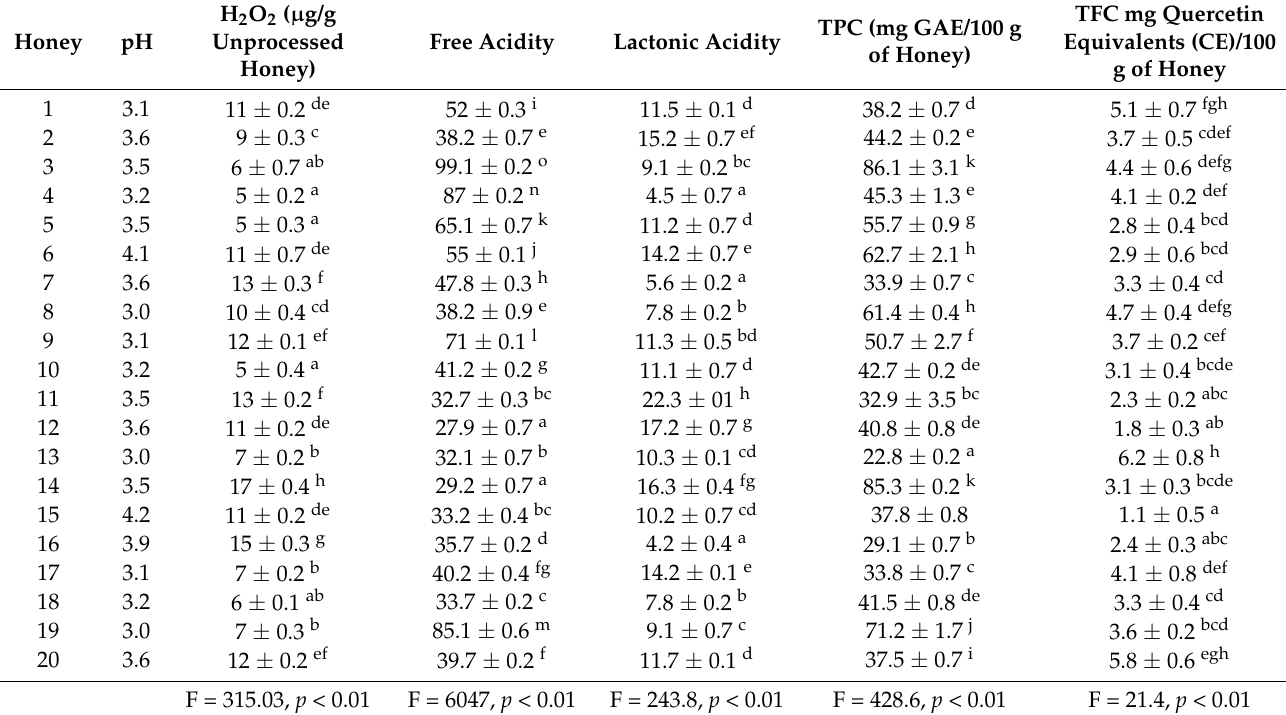
Table 6. Physicochemical characteristics of the 20 oregano and sage honey samples.